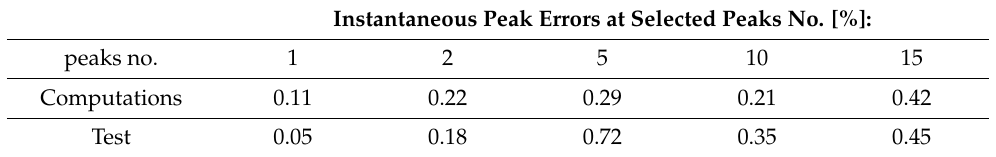
Figure 5. A prototype of a two-stage cascade current transformer 50 kA/5 A for the short-circuit current measurements during tests on a test stand in a short-circuit test laboratory. Table 2. A summary of the results of the prototype short-circuit tests 50 kA/5 A at the time constant Tp = 190 ms, Kssc = 2.76, and load R = 0.88 Ω